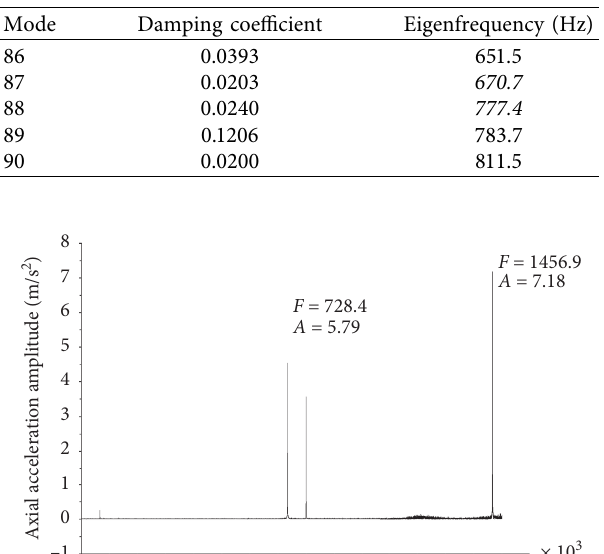
Table 8: Modified eigenfrequencies (segmental).